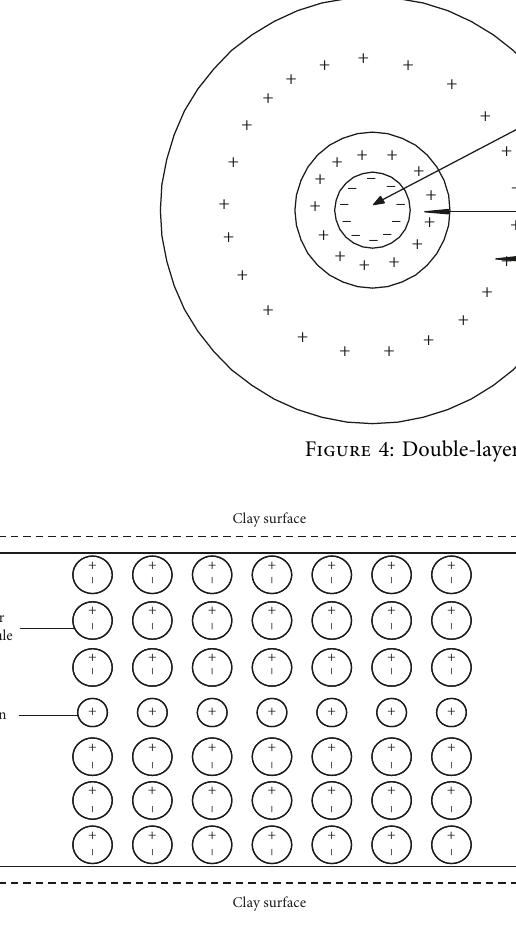
Figure 5: Arrangement structure of adsorbed water between clay